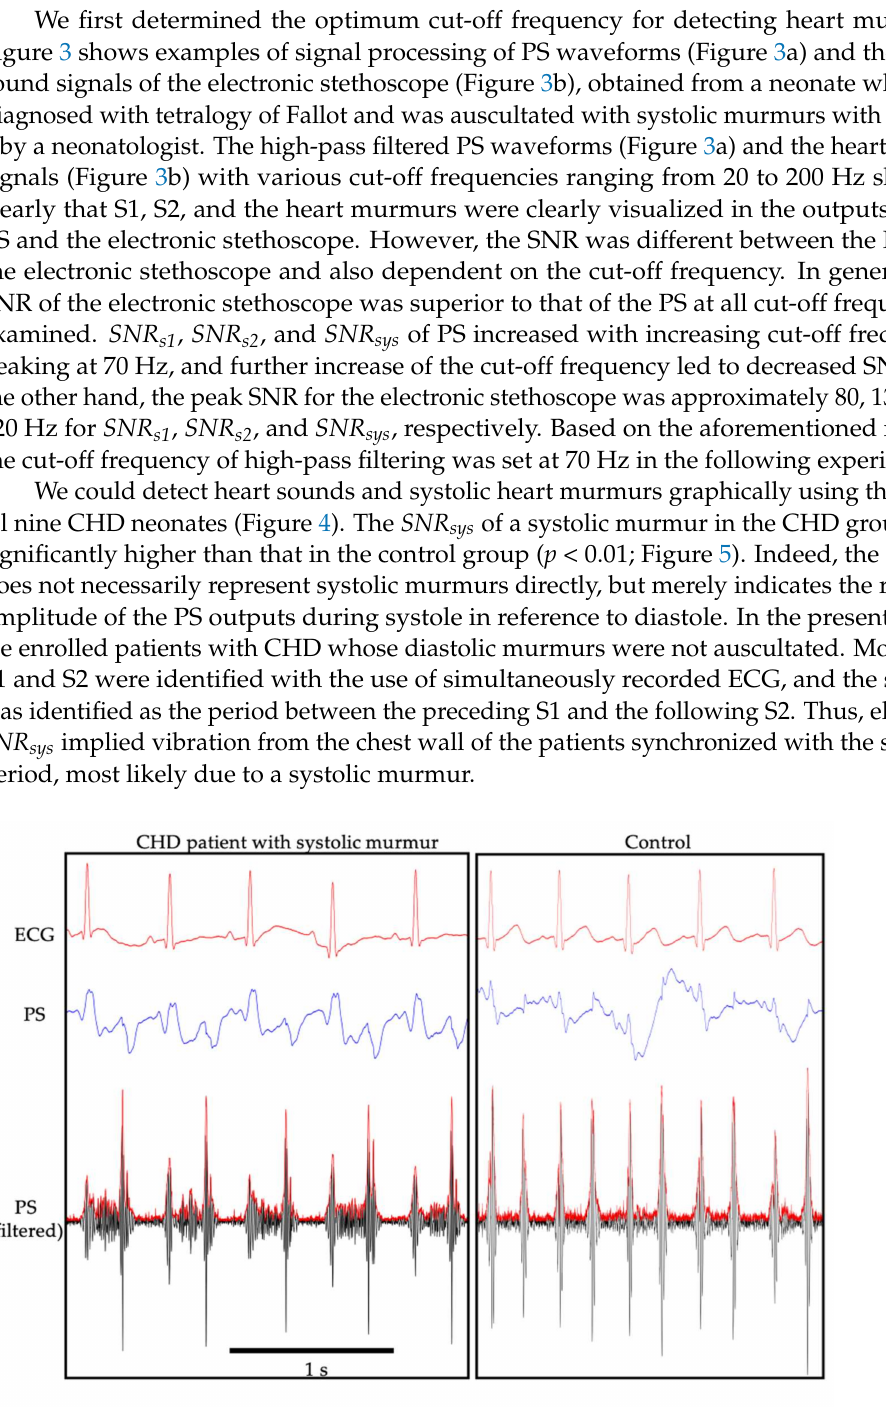
Figure 4. A representative recording using the piezoelectric sensor (PS) in a patient with congenital heart defects with systolic murmur (left) and that of a control (right). Electrocardiogram (ECG) signal (upper), PS output (middle), and PS output filtered by high-pass filtering (bottom) are